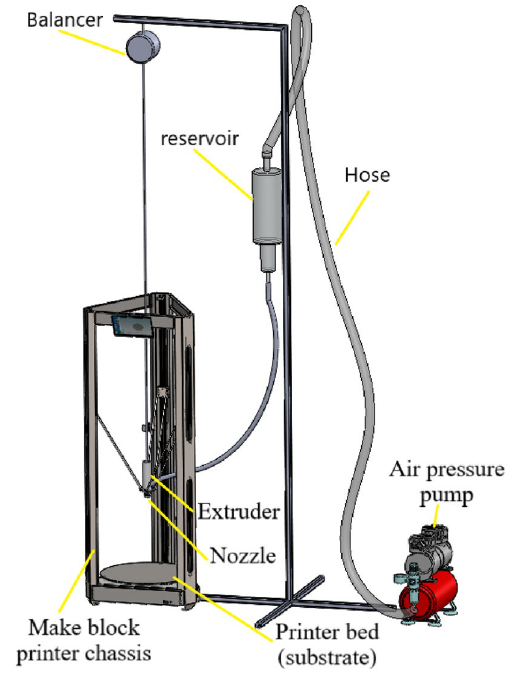
Fig. 5 Primitive concept design for 3D printer ceramic after conver-